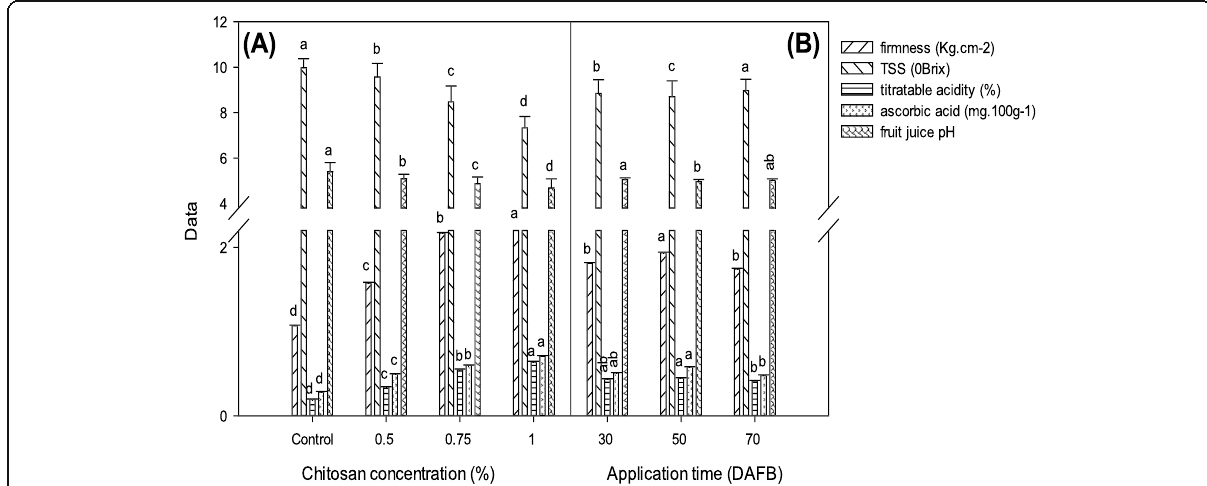
Fig. 2 Fruit firmness, total soluble solid, fruit juice pH, titratable acidity, and ascorbic acid of peach as influenced by different chitosan concentrations and application time. The vertical bars represent standard error. Different letters next to the mean values in each bar indicate a significant difference (LSD p ≤